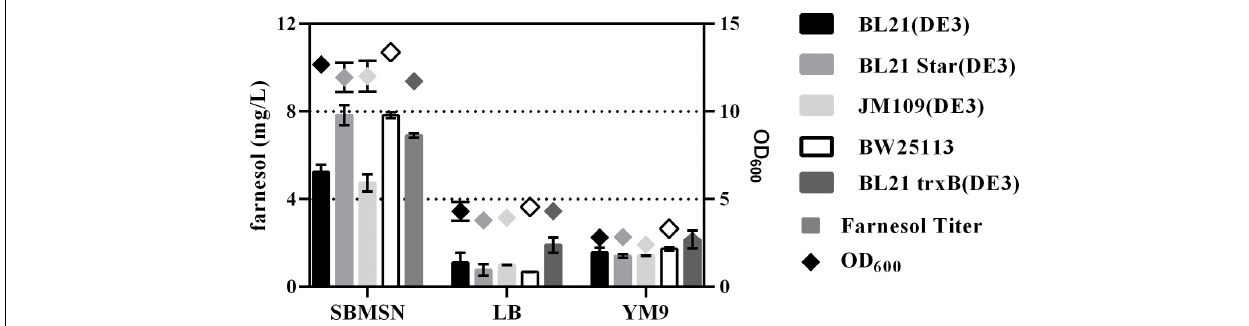
FIGURE 1 | Effect of medium and strains on farnesol yield and OD 600 in E. coli hosts carrying pMM.